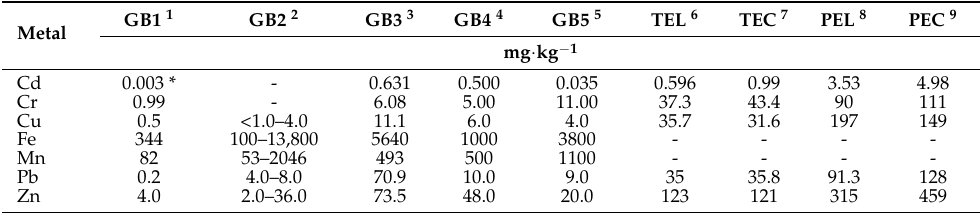
Table 3. Threshold values of geochemical backgrounds (GB1–GB5) and sediment quality guidelines (TEL, TEC, PEL, PEC) implemented for the assessment of the chemoecological state of Wigry